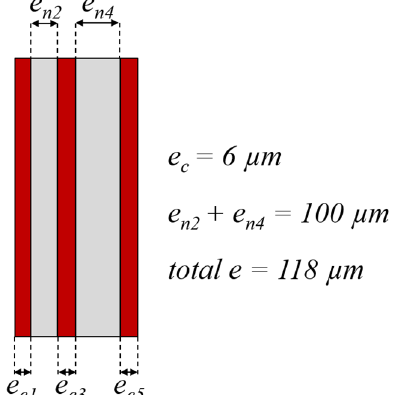
Figure 7. Three layers configuration (Cu-6 µm/Ins- e (cid:2924)(cid:2870) /Cu-6 µm/Ins- 𝑒 (cid:3041)(cid:2872) /Cu-6 µm) with an asymmetry between insulating layers for the same total thickness of 100 µm.